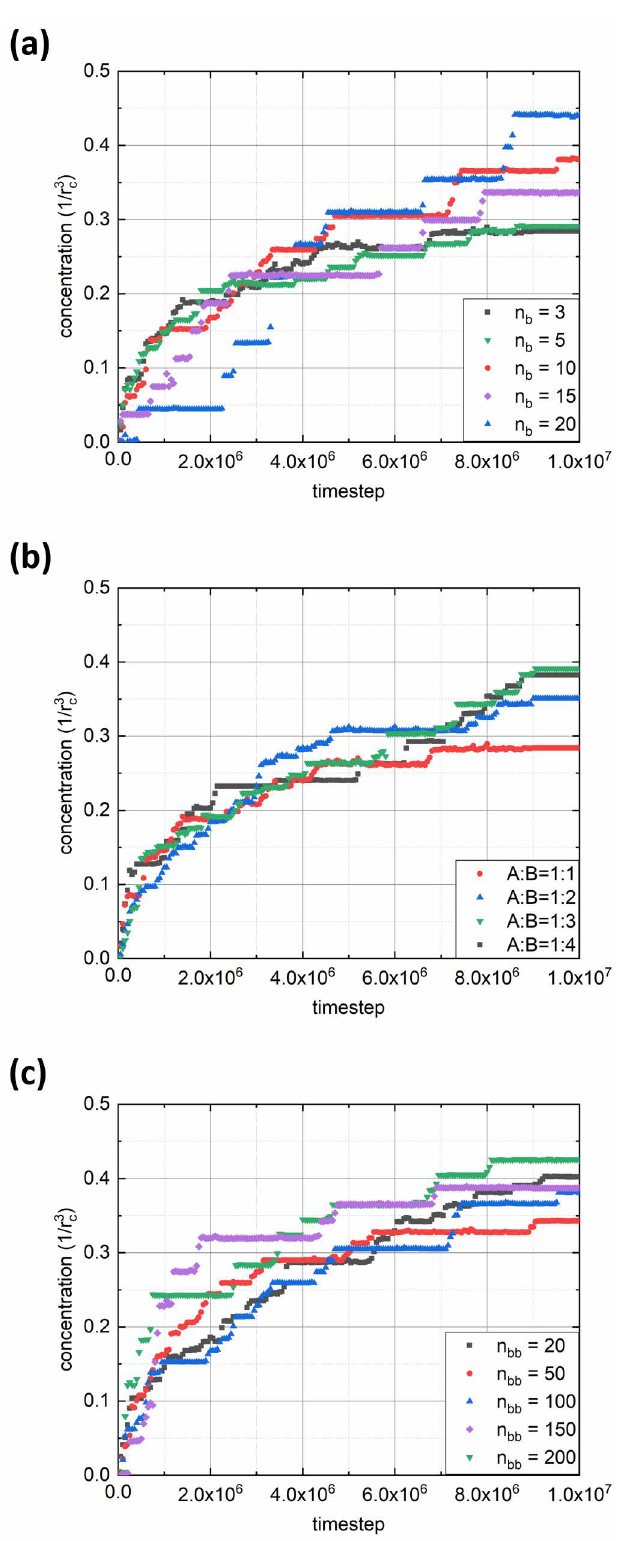
Figure 3. Evolution of polymer concentration at the liquid interface over time. Each graph depicts the effects of different parameters of the macromolecular architecture: ( a ) solvophobic side chain length ( n bb = 100 and f a = 0.5); ( b ) ratio between solvophilic and solvophobic side chains A:B ( n b = 3 and n bb = 100); and ( c ) backbone length ( n b = 10 and f a =